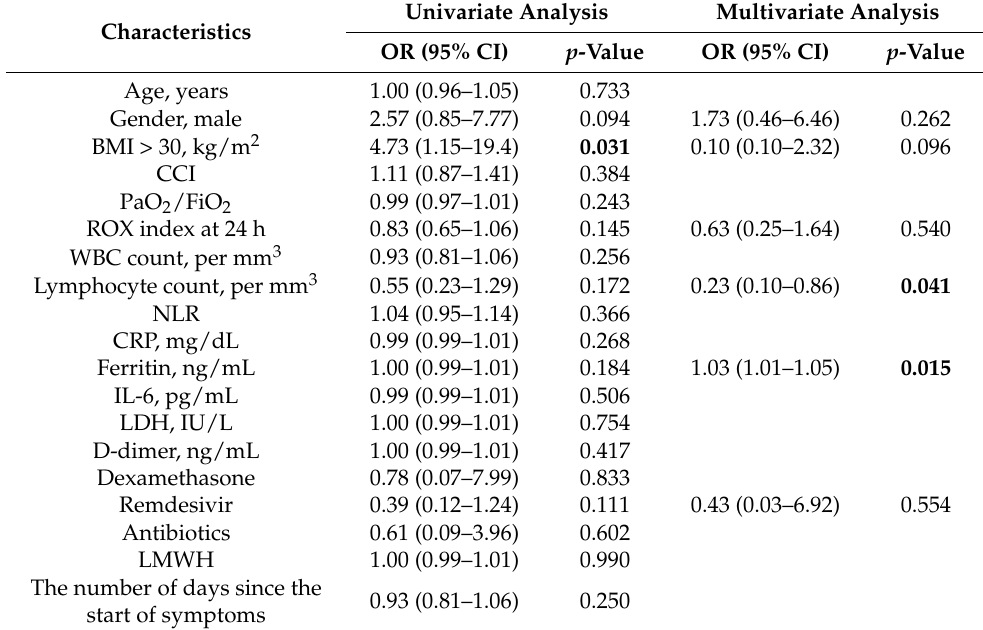
Table 3. NIV failure